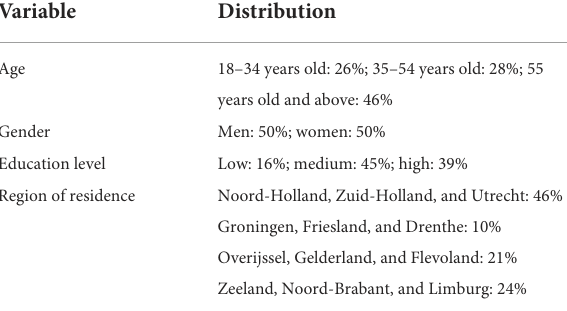
TABLE 1 Demographics of the initial